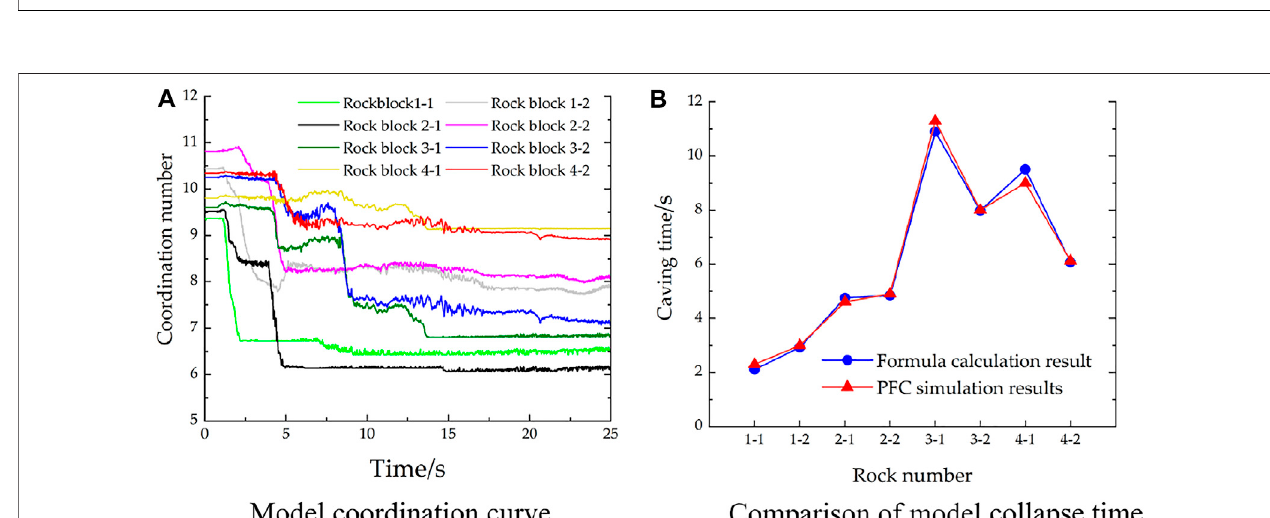
FIGURE 9 | (A) Coordination number and (B) destruction time.